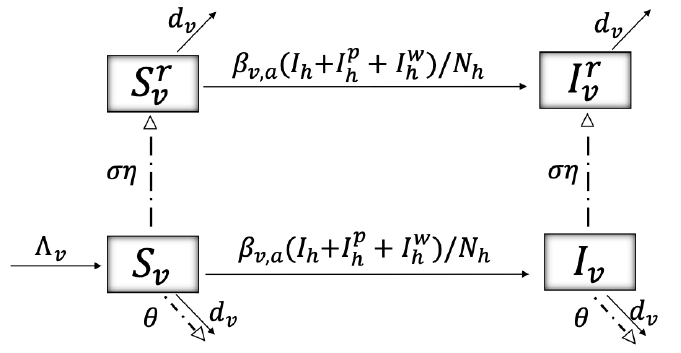
Figure 2. Schematics showing the flow between malaria disease states for mosquitoes: susceptible, S r v and S v , and infectious, I r v and I v , representing insecticide-resistant and non-resistant mosquitoes, respectively. The dashed-dotted lines represent discrete moments in time when mosquitoes are exposed to the insecticide, and the solid lines represent continuous rates. A description of the variables and parameters shown can be found in Tables 1 and 2, respectively.